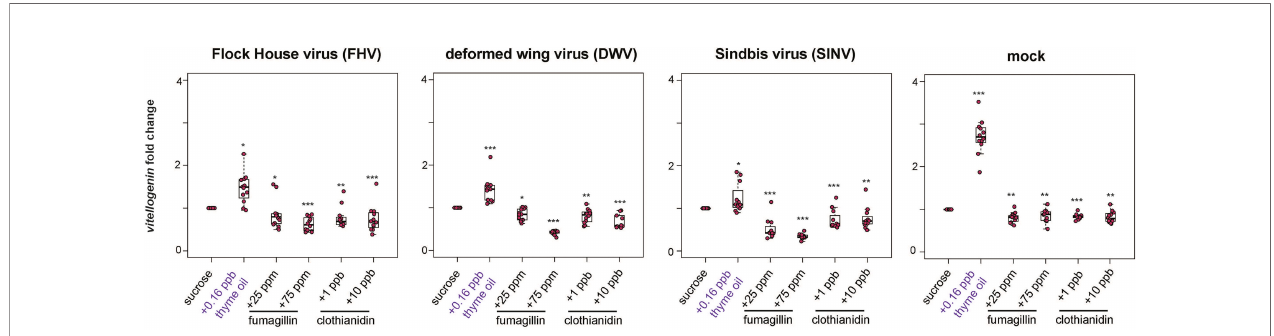
FIGURE 6 | Vitellogenin expression was higher in bees fed sucrose syrup containing thyme oil and lower in bees fed sucrose syrup containing fumagillin or clothianidin. Vitellogenin expression was assessed using qPCR and the relative gene expression was analyzed using the DD Ct method with normalization to rpl8 and relative to expression in mock or virus-infected bees fed sucrose syrup only. In virus-infected (i.e., FHV, DWV, SINV) and mock-infected honey bees vitellogenin expression was greater in bees fed sucrose syrup containing thyme oil 0.16 ppb and reduced in bees fed sucrose syrup containing fumagillin (25 ppm or 75 ppm) or clothianidin (1 ppb or 10 ppb) relative to sucrose only fed bees. Asterisks indicate a signi fi cant change in gene expression compared to sucrose only control; signi fi cance levels: * p < 0.05; ** p < 0.005; *** p < 0.0005. This fi gure shows representative biological replicate for vitellogenin expression. The data for one additional biological replicate is presented in Supplemental Figure S9 . Raw data are included in Supplemental Tables S21,